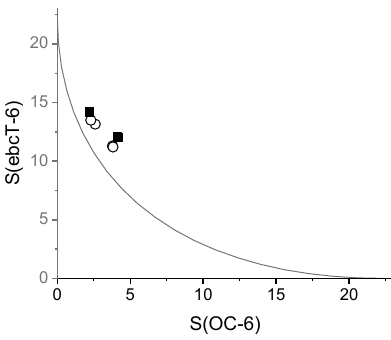
Figure 4. Shape maps for [Fe( L ) 2 ] 2 + . S(OC-6) and S(ebcT-6) are octahedral and edge-bicapped tetrahedral symmetry measures, respectively, with a line representing minimum distortion pathway between these reference shapes. Open circles and black squares correspond to the coordination geometry from X-ray diffraction (Table 2) and quantum chemistry calculations (Table S1), respectively.